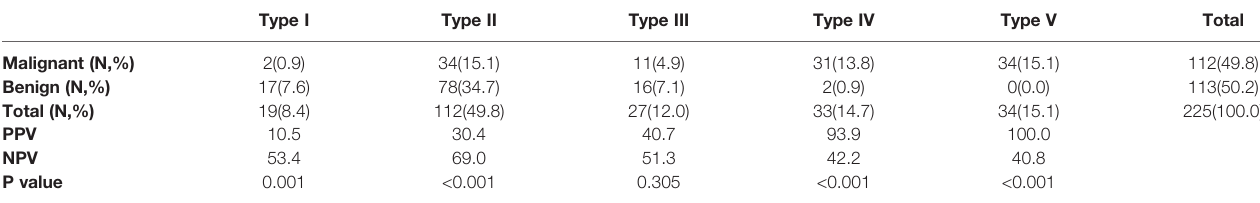
TABLE 3 | Classi fi cation and diagnostic ef fi cacy of 3D-SMI VA in benign and malignant lesions. Type